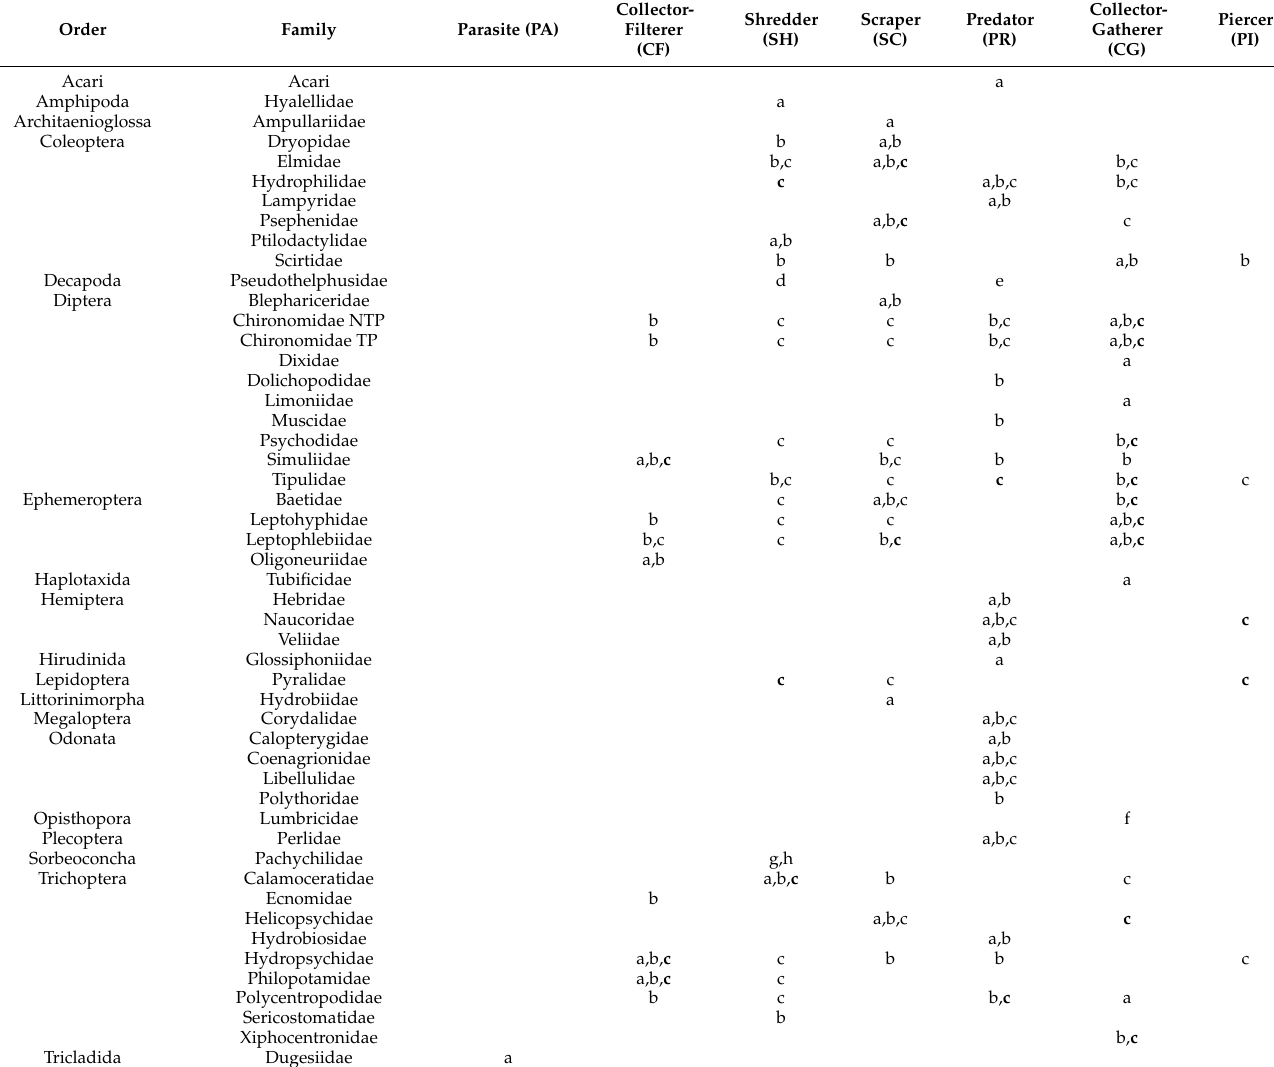
Table A1. List of all orders, families, and functional feeding group (FFG) assigned based on available information, encountered in the Coca and Aguarico River basins. Cited reference (a) Damanik-Amabrita et al. [27], (b) Ramirez & Gutierrez [71], (c) Tomanova et al. [72], (d) Yang et al. [74], (e) Wehrtmann et al. [73], (f) Nessimian et al. [75], (g) Dudgeon & Gao [69] and (h) Niu & Dudgeon [70]. The bold “c” letters indicate the FFG that Tomanova et al. [72] assigns the highest feeding